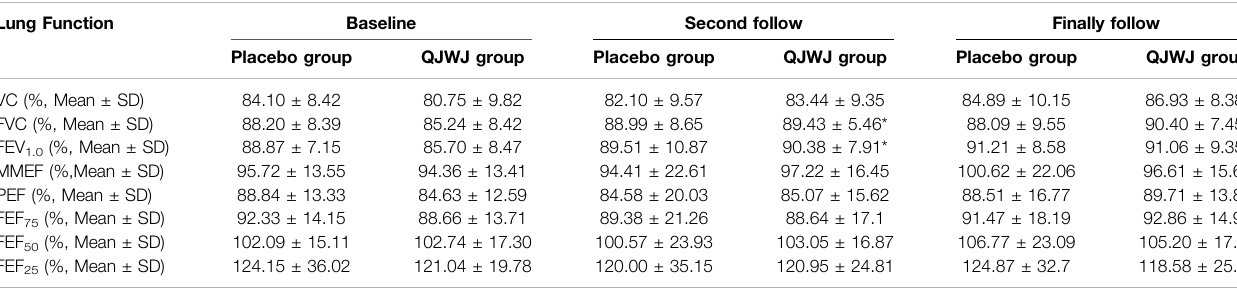
TABLE 4 | The difference of lung function parameters between groups in different periods. Lung Function Second follow Finally follow